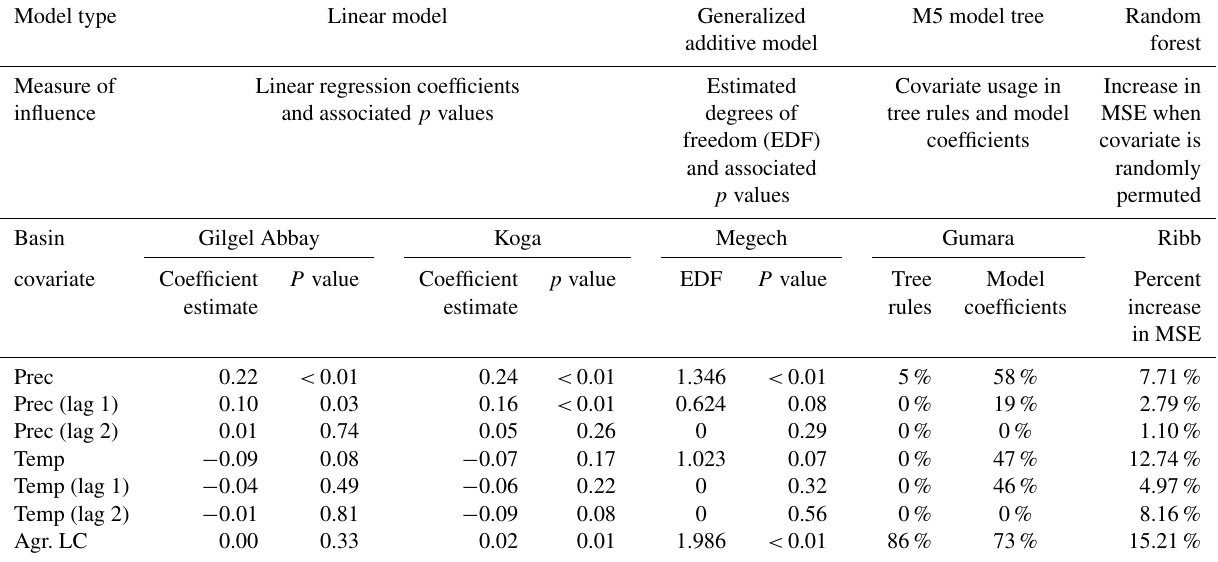
Table 5. Covariate importance measurements from each basin’s model.